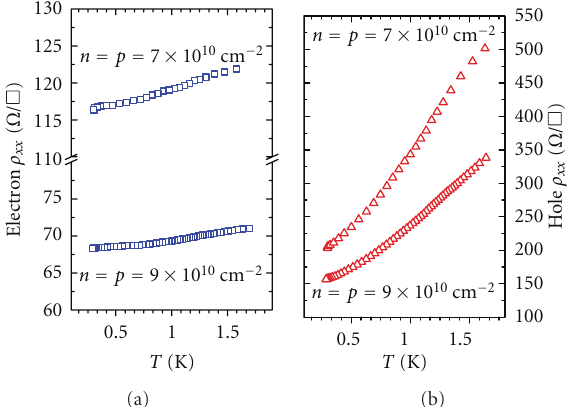
Figure 20: Resistivities of hole and electron layers versus tempera- ture for n = p = 7,9 × 10 10 cm − 2 , with 25nm Al 0 . 3 Ga 0 . 7 As barrier. (Device: B135/C3-4-25nm Barrier).